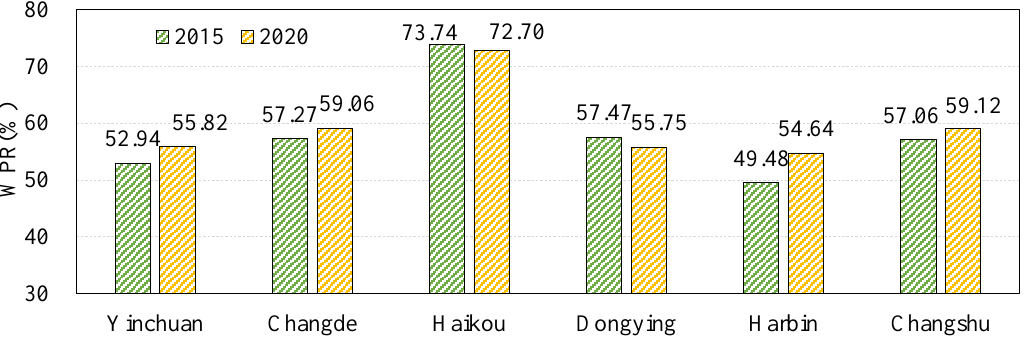
Figure 10. Wetland protection rate (WPR) for 6 cities in 2015 and 2020.